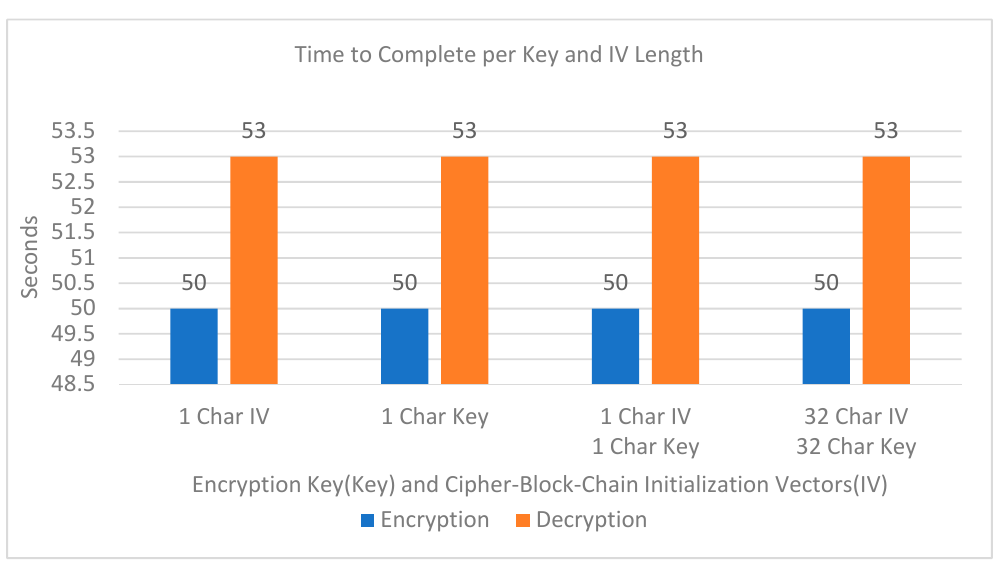
/ decryption remained the same regardless of key or IV Figure 8. Time to complete encryption/decryption remained the same regardless of key or IV length. Figure 8. Time to complete encryption